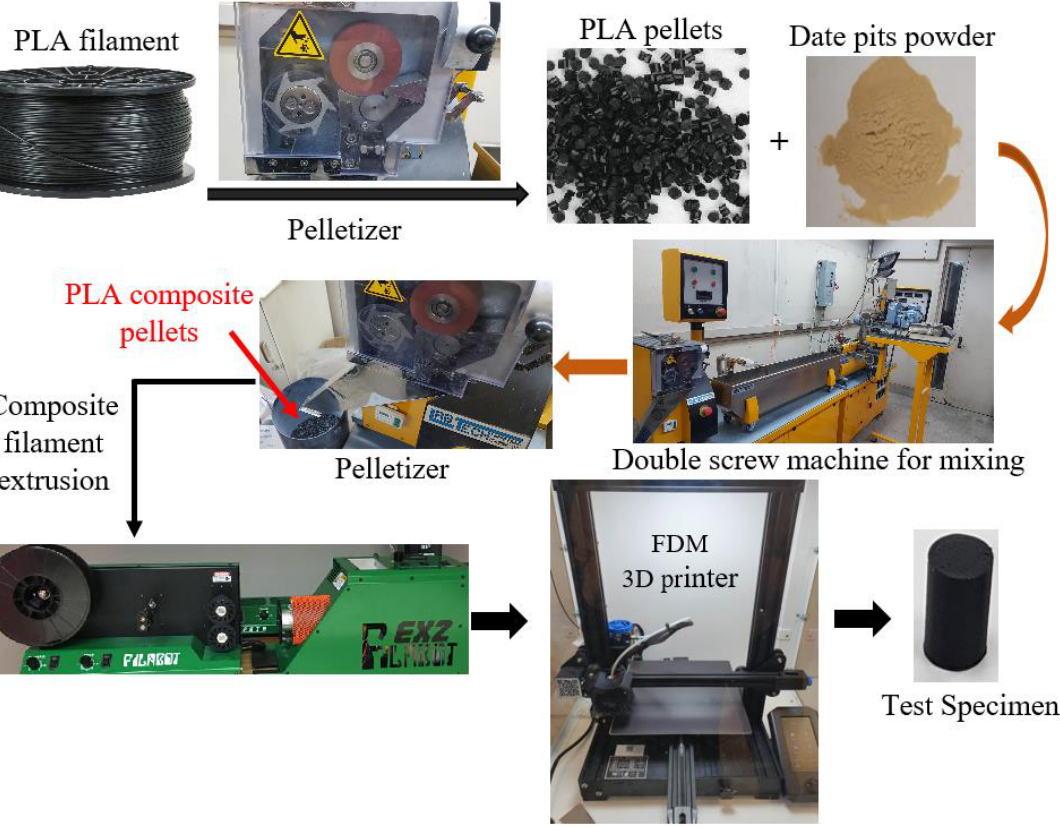
Figure 2. Flowchart of PLA – date pit composite filament production and the fabrication of test specimens using an FDM 3D printer.